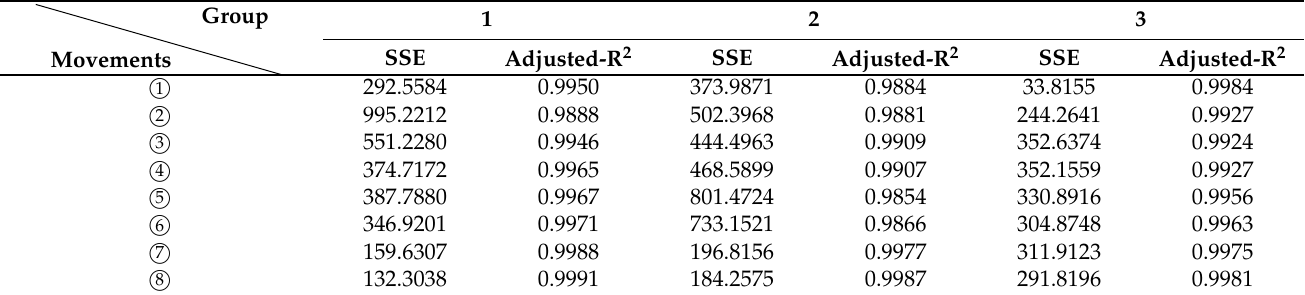
Table 3. Fitting results of the spine curves of eight